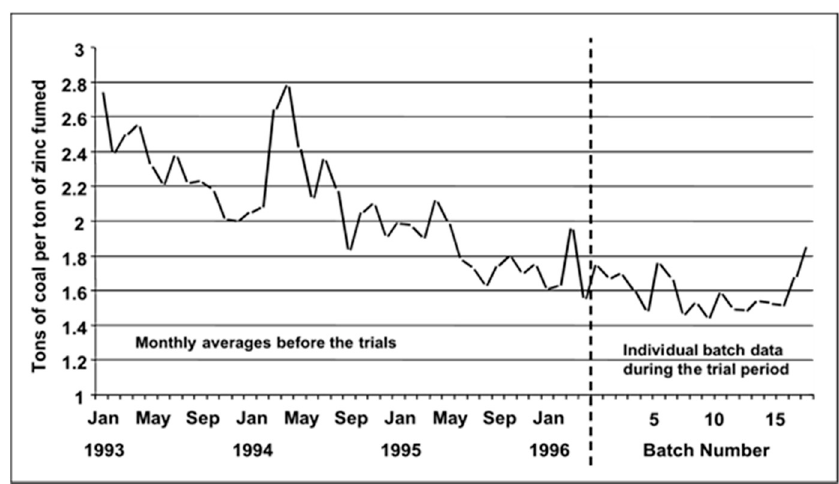
Figure 16. Influence of plastics on the energy balance in the furnace [96].